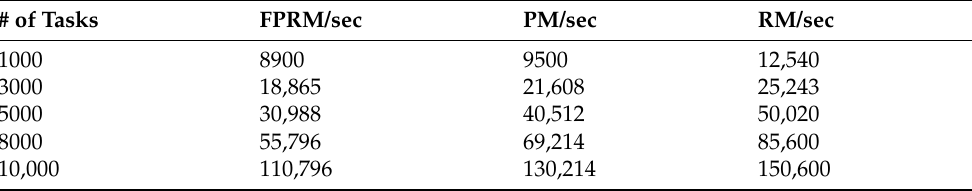
Table 3. Simulation results of TTT in different scenarios.